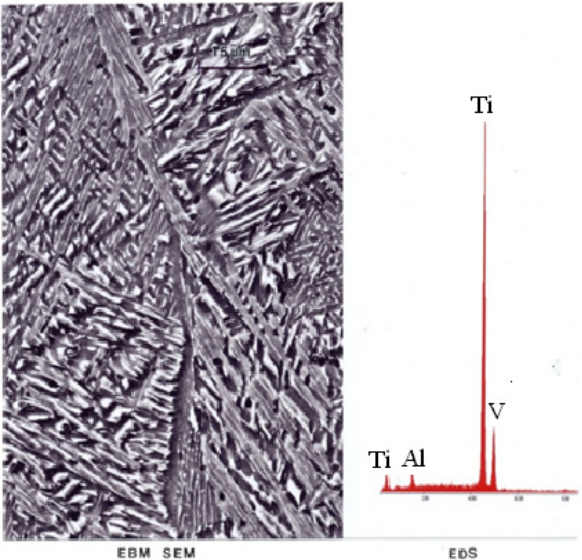
Figure 7. SEM and EDS for EBM